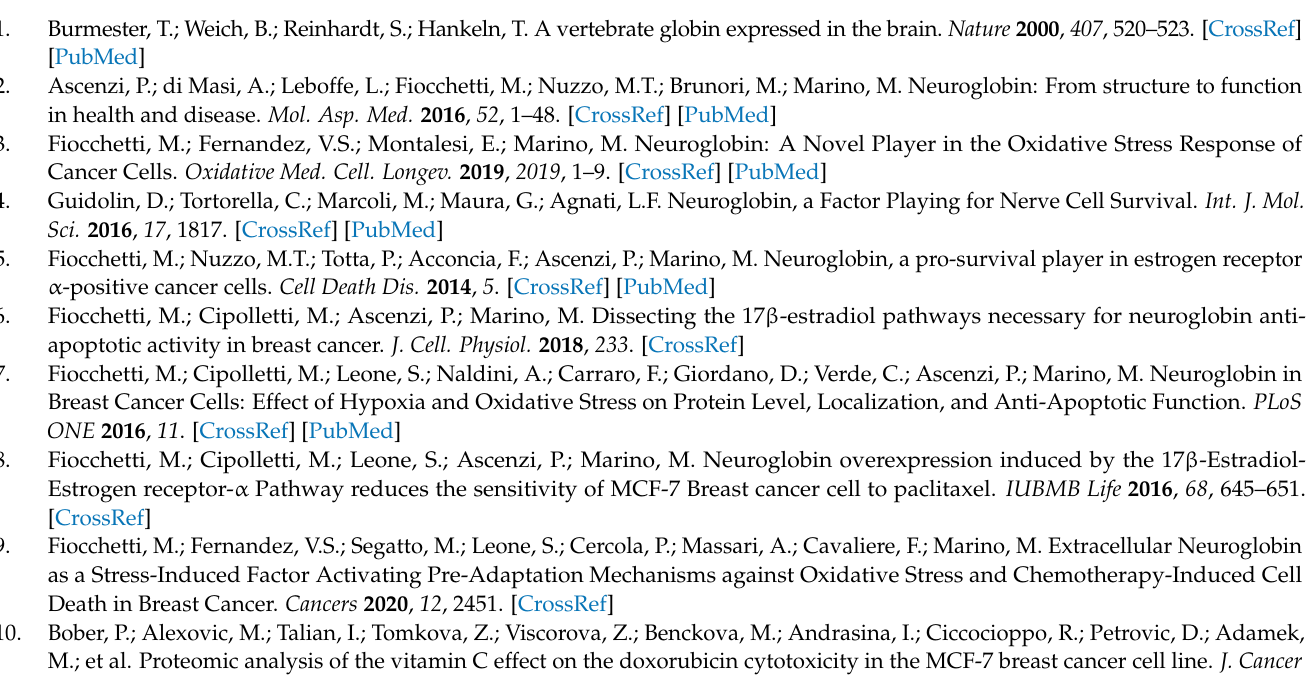
MCF-7 cells, Supplementary Table S1: List of the differentially regulated proteins in the NGB-KO vs. Neg proteome, Supplementary Table S2: List of the differentially regulated proteins in the NGB-KO + E2 vs. Neg + E2 proteome, Supplementary Table S3: List of the differentially regulated proteins in the NGB-KO + H 2 O 2 vs. Neg + H 2 O 2 proteome, Supplementary Table S4: List of the